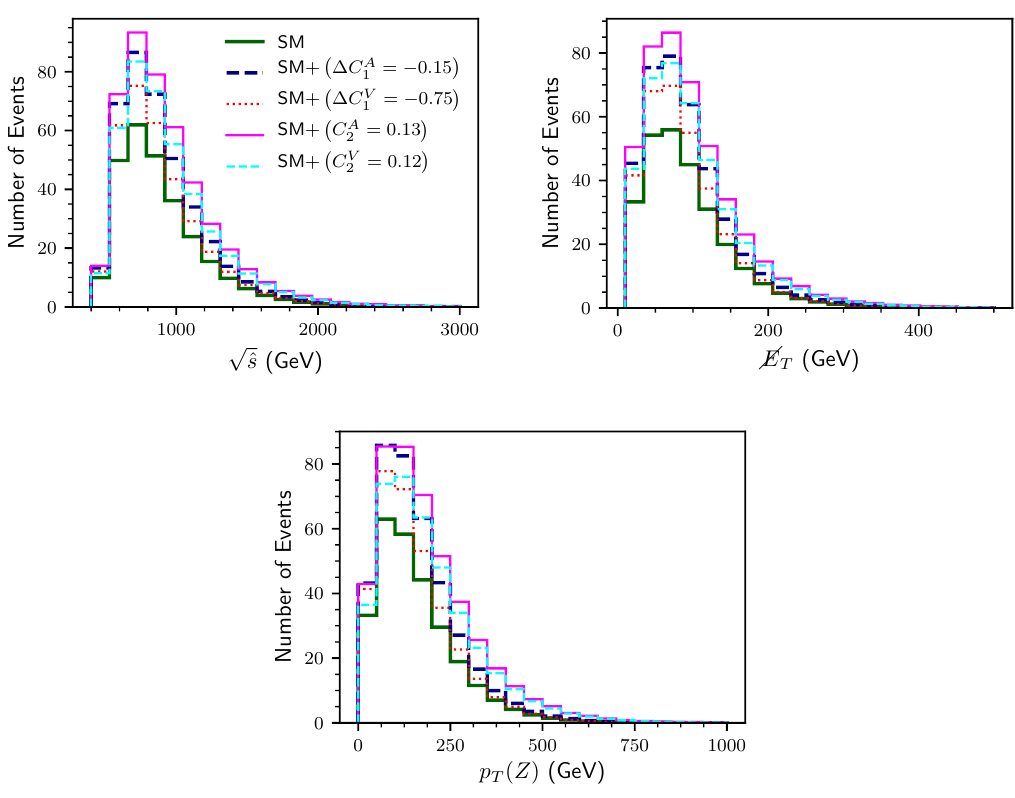
√ ˆ s , (cid:0) E , and p ( Z ) in 2 e + 2 µ + 2 b + (cid:0) E T T